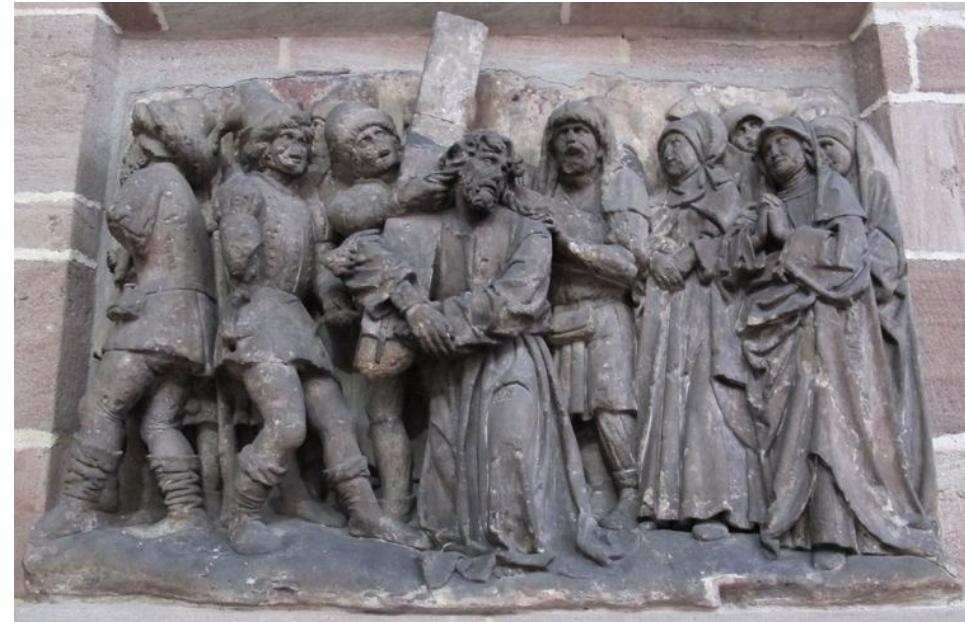
Figure 17. Kraft, Stations of the Cross, Nuremberg, Station Three (Nuremberg, Germanisches Nationalmuseum).